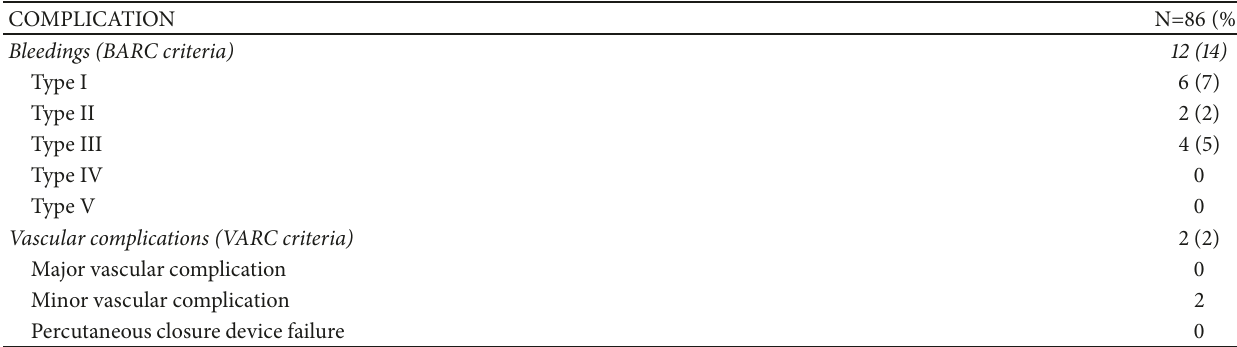
Table 3: Periprocedural bleeding and vascular